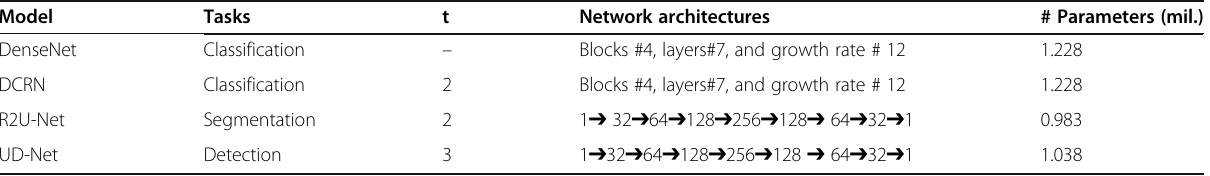
Table 1 The model architectures and the number of network parameters utilized for each model Model